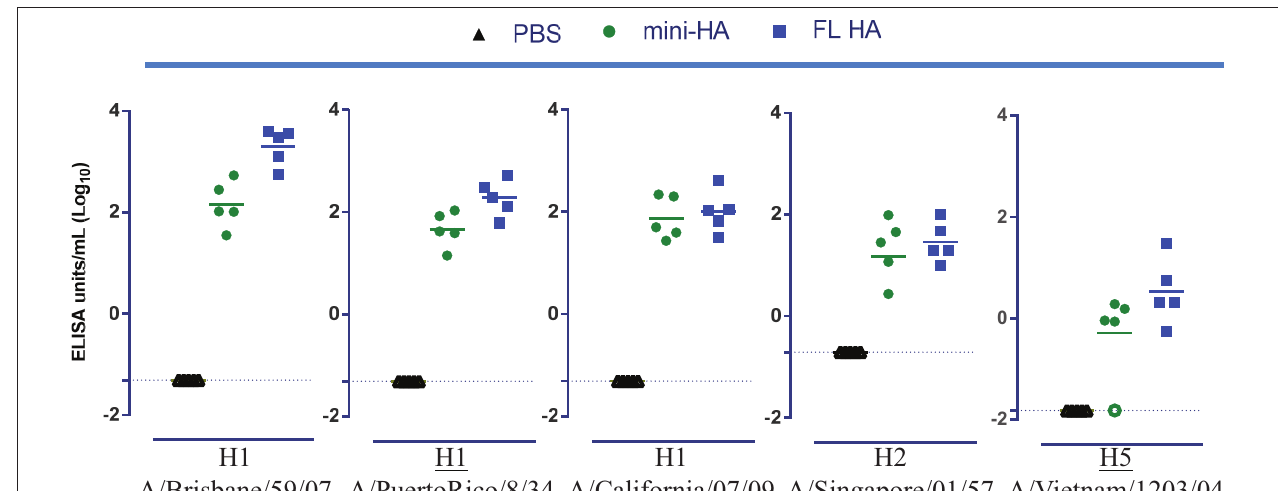
FIGURE 2 | Similar titers of antibodies binding to a panel of group 1 FL HA induced by mini-HA and H1 FL HA immunization. Serum samples taken 4 weeks after the third immunization were analyzed for binding to a panel of group 1 influenza FL HA by ELISA. Results of mock immunization (PBS) or immunization with 103 nmol antigen are shown. 103 nmol results are representative for all doses tested, see Supplementary Figures 1, 3 for ELISA titers of all doses. Solid lines indicate the group means, dashed lines indicated the LOD. Open symbols represent samples at LOD. All serum samples taken from mock immunized mice are on LOD. Underlined influenza strains represent the FL HA homologous to, or the same subtype of, the challenge strains, see materials and